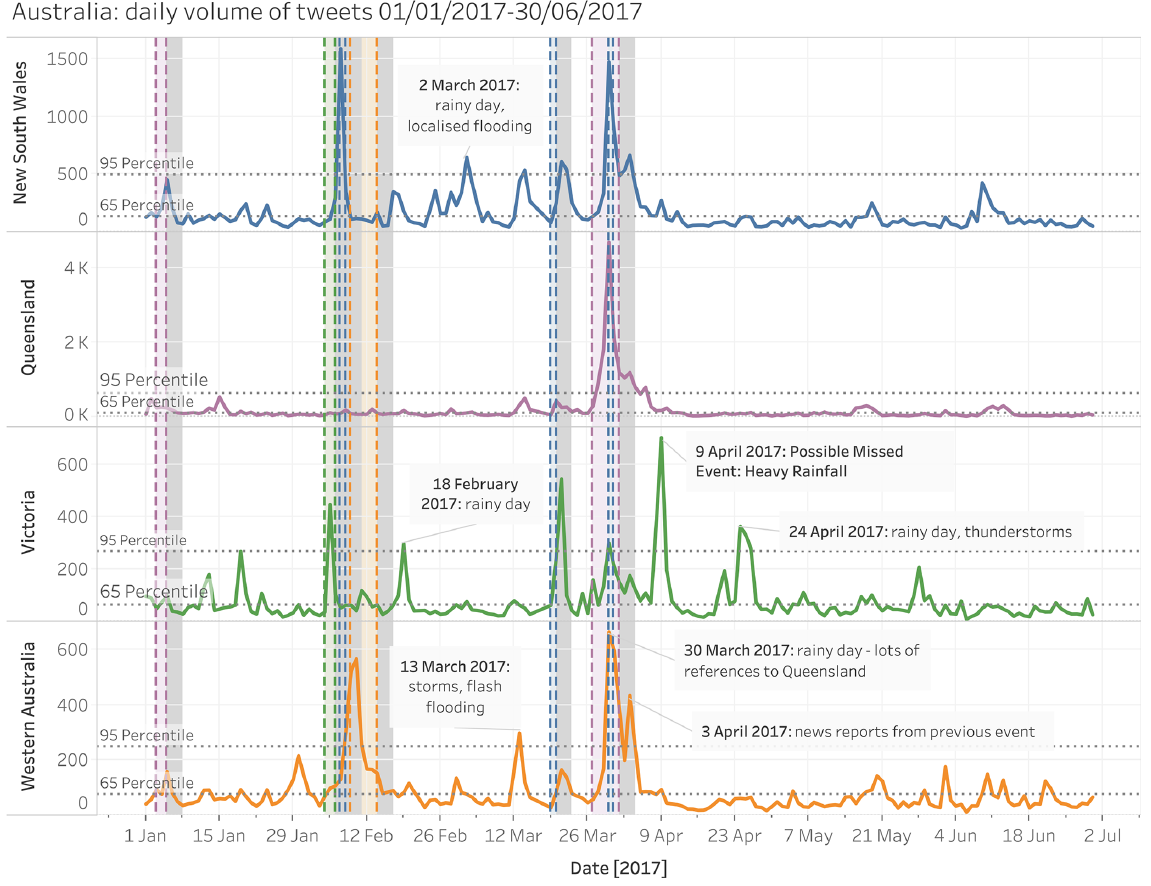
Figure 5. Time series of filtered tweet counts per day for each of the Australian administrative areas with events in the Met Office database. The period of each heavy rainfall event in the Met Office database is shown by a shaded bar colour coded to the administrative area. The 3d after each event is shown by a grey shaded bar. Social sensing events that are not present in the Met Office database are